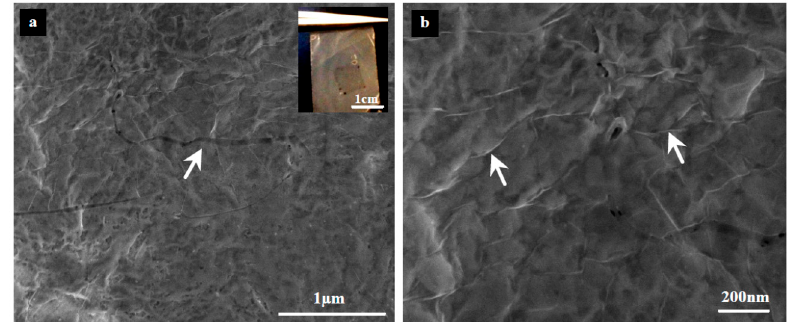
Figure 14. FESEM micrograph of transferred graphene (~1 × 1 cm 2 ) onto PVDF 5 substrate. The white arrow on the left image indicates the tears in the graphene upon transfer [54].